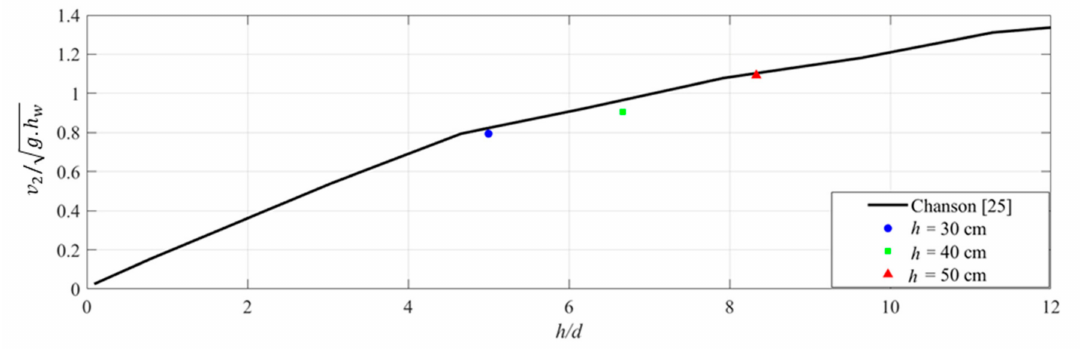
Figure 13. Tests with the wet bed condition flow velocity compared to Chanson’s [25] graphical solution.